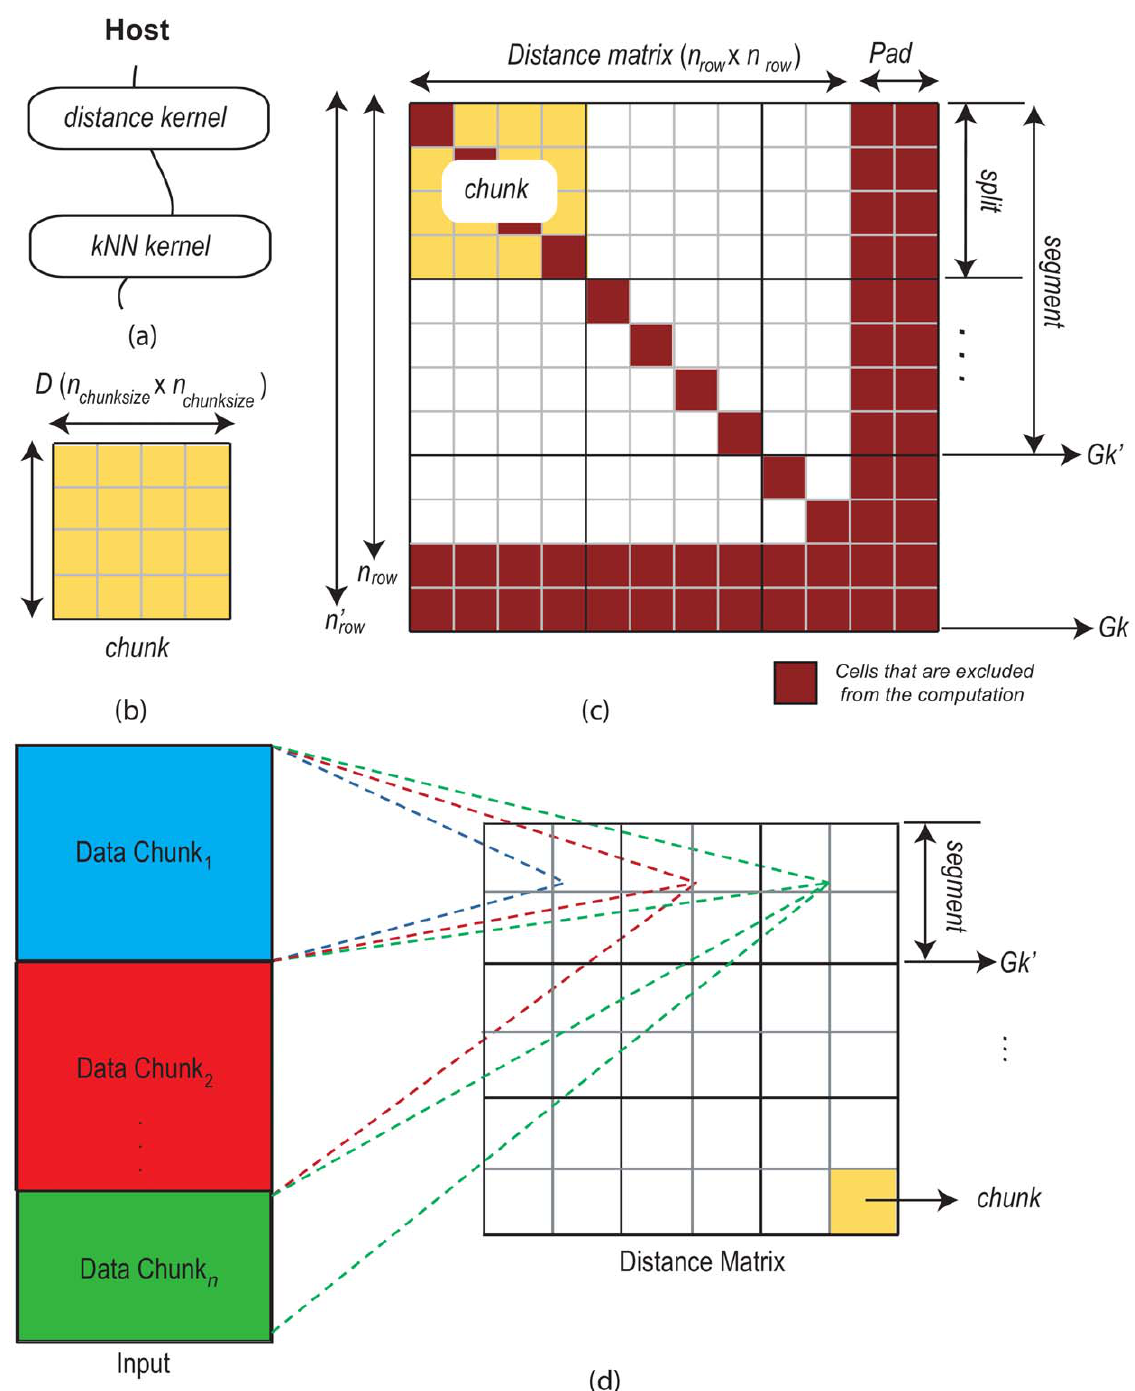
Figure 5. Basic principle of the proposed method. Figure (a) shows two kernels that execute sequentially, the first one creates the distance matrix and the second one identifies the nearest neighbours. Figure (b)–(c) shows the proposed method of computing k NN using chunk, split and segment of the original matrix. The original matrix is never kept in the device memory, each time a chunk is computed and respective k NNs are identified. Figure (d) shows an illustrative chunking of data for further scalability by splitting the data set horizontally into n number of data chunks. doi:10.1371/journal.pone.0044000.g005 n row number of rows and n col number of columns. Since, CUDA ( n row | n col ), the distance matrix chunks in a single dimensional programming API does not support the transferring of multidi- array D of length ( n chunksize | n chunksize ), given a fixed chunk size, n chunksize and the resultant k NN graph ( Gk ) in an array of 3-tuples mensional arrays from the host to device memory [19], we store the input matrix in a single dimensional array In of length {source, target, weight} of length ( k | n row ). Additionally, we store